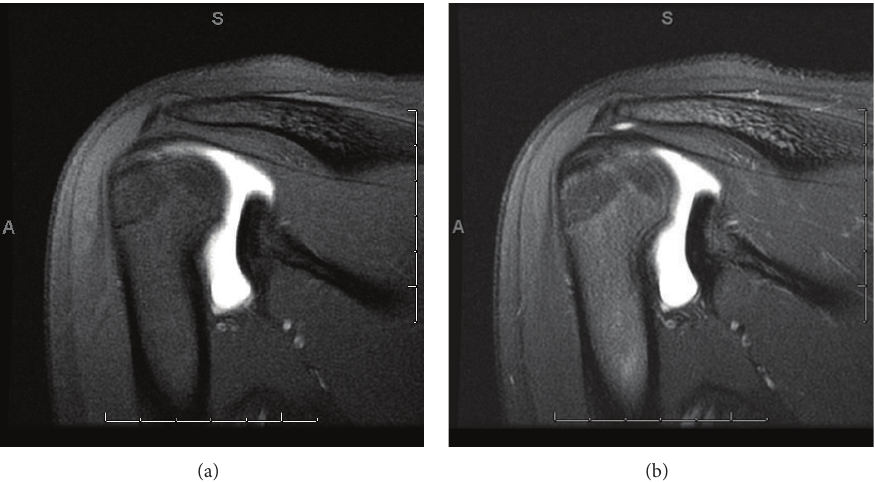
Figure 6: Case 12 . HAGL not identified on initial report. Oblique coronal T1 fat saturated and oblique coronal T2 fat saturated images demonstrate J sign of MR arthrogram. No other findings were